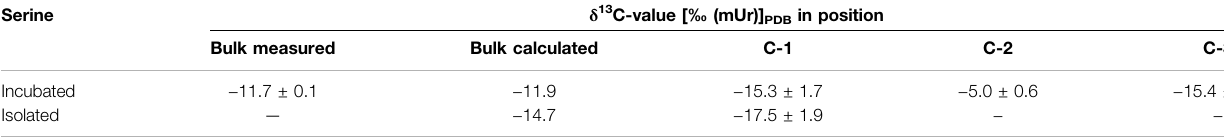
TABLE 1 | δ 13 C-values of serine and of its molecule positions before and after isolation from incubation medium. Serine